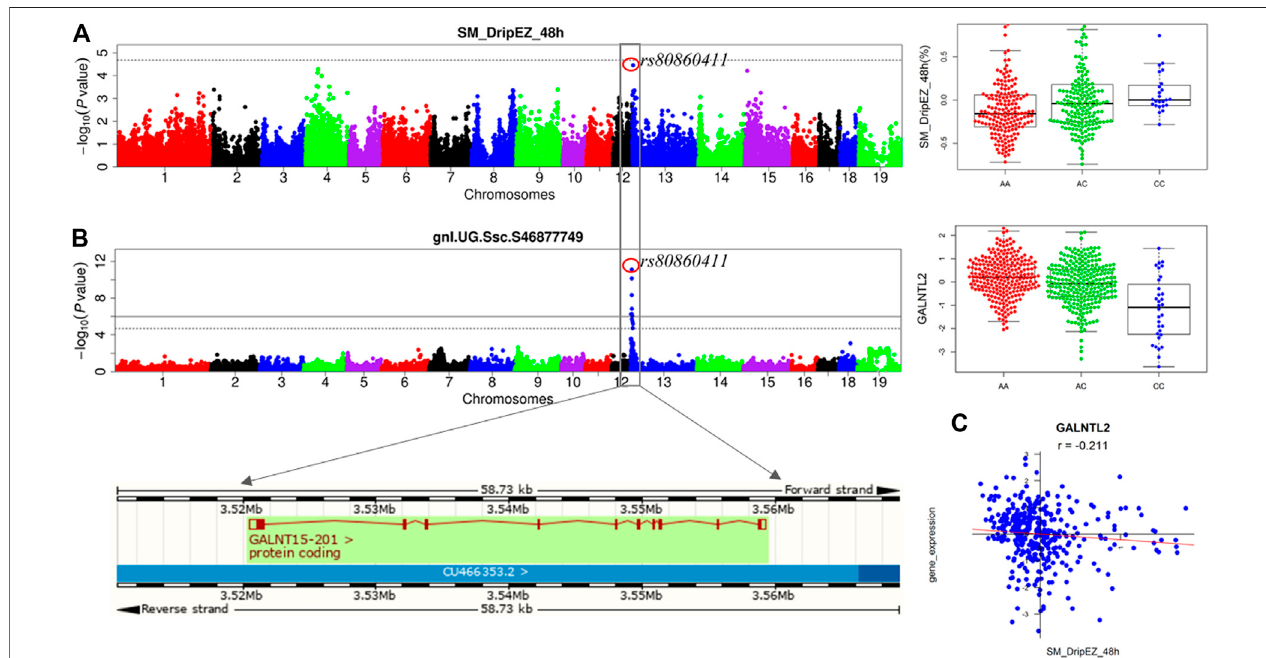
FIGURE 4 | Integrating analysis of pQTL, eQTL, and QTT identify candidate gene GALNT15 in fl uencing drip loss. (A) The results for GWAS and the phenotype distributionforthreegenotypesofthepeakSNPrs80860411onSSC13. (B) TheresultsforeQTLmappingandthegeneexpressionleveldistributionforthreegenotypes of the peak SNP rs80860411 on SSC13. The phenotype/expression level distribution adjusting for sex and batch. (C) The correlation coef fi cient between drip loss phenotype data and gene expression level.